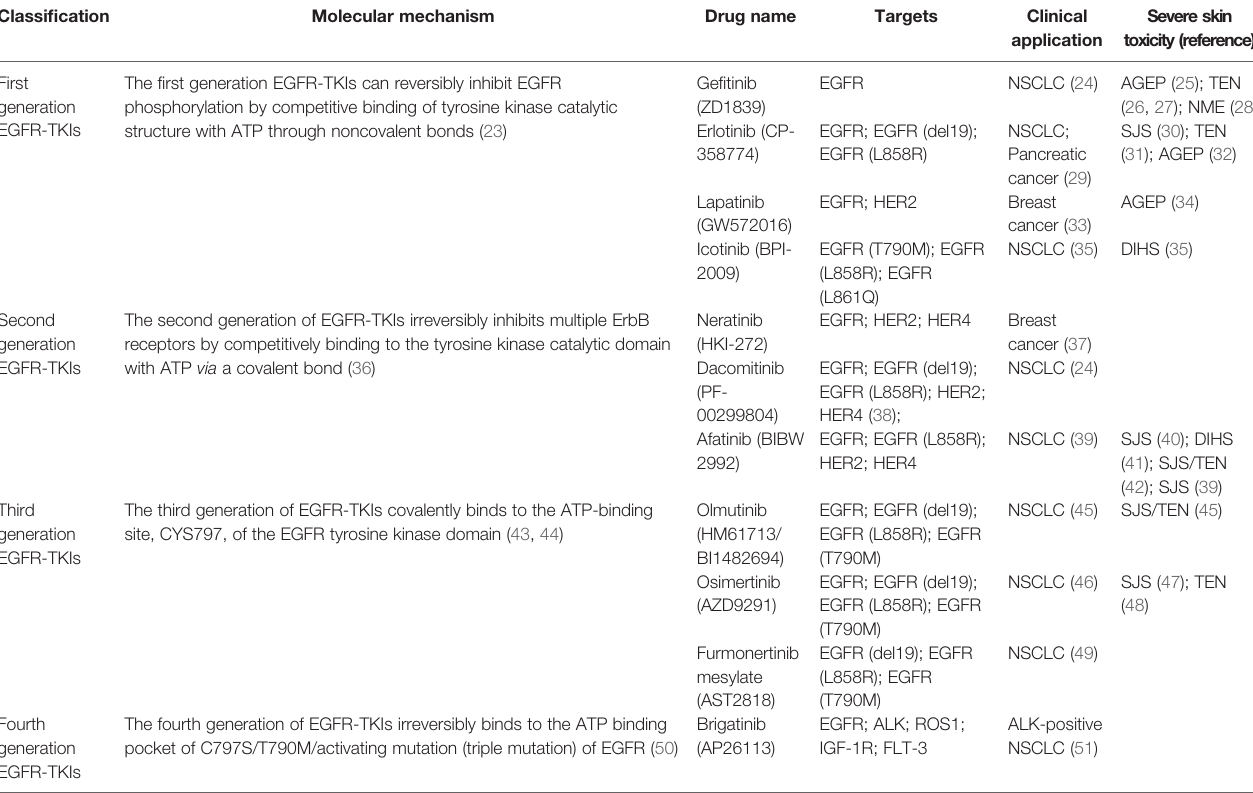
TABLE 1 | Clinically used EGFR-TKIs.